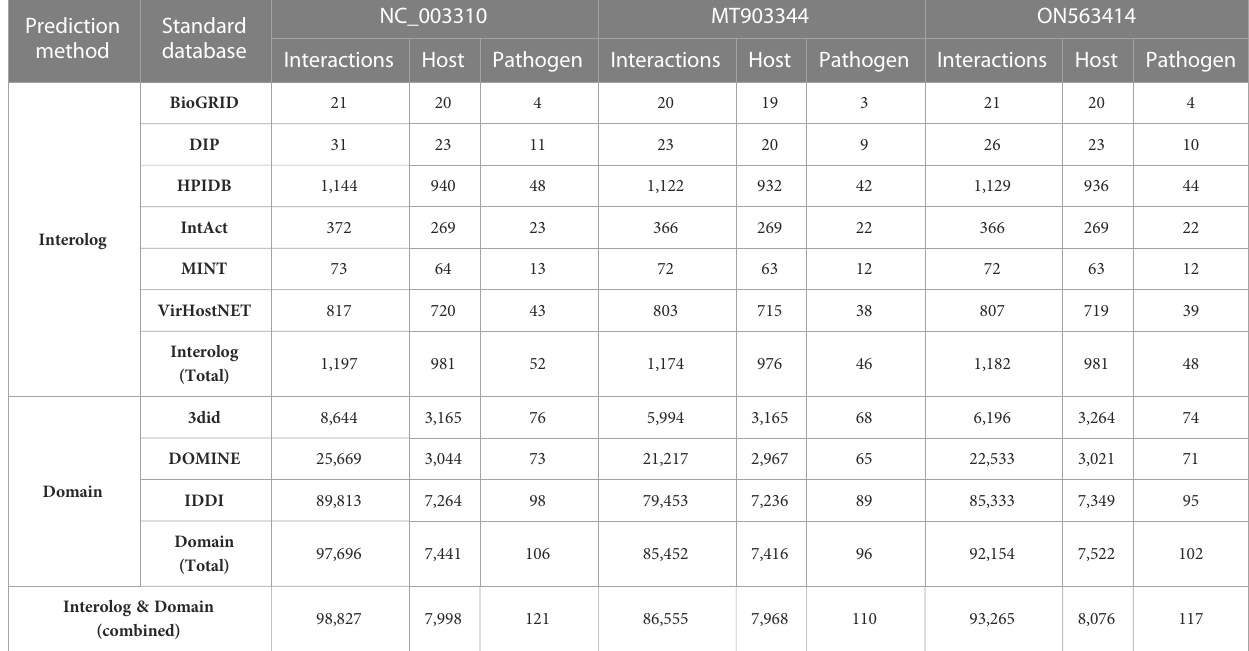
TABLE 2 Protein-protein interactions prediction from Interolog- and Domain-based approaches using BLAST parameters: 50% sequence identity, 1 e - 05 e -value, and 50% sequence coverage. Prediction